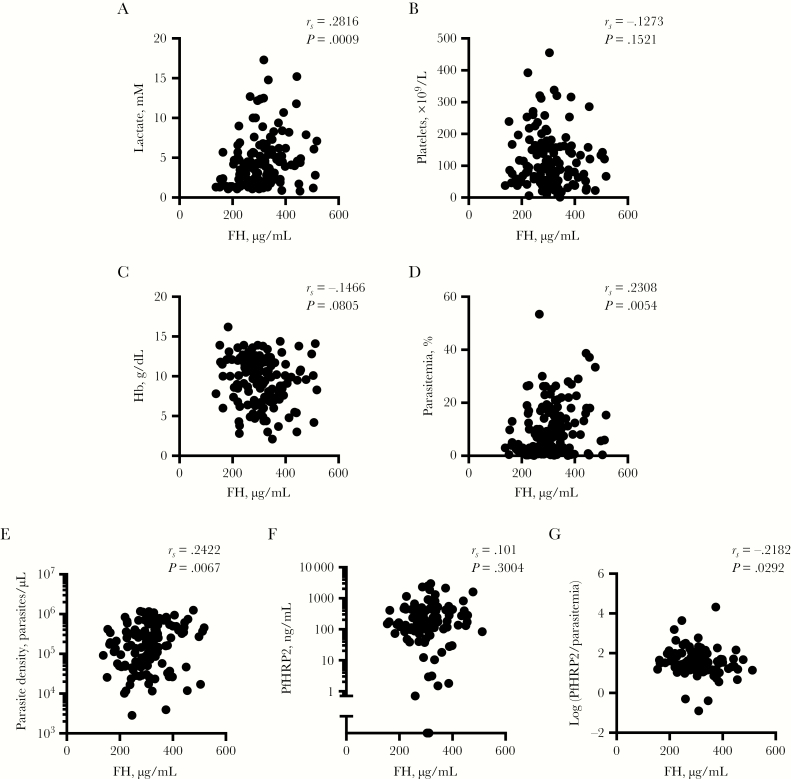
Factor H (FH) plasma levels associate with severity markers. A–D, Correlations of FH plasma levels with severity markers at the time of presentation to hospital: (A) lactate, (B) platelets, (C) hemoglobin (Hb), (D) parasitemia (% of infected erythrocytes in blood film), (E) parasite density, (F) PfHRP2, (G) sequestration index [log (PfHRP2/parasitemia)]. Spearman’s correlations.